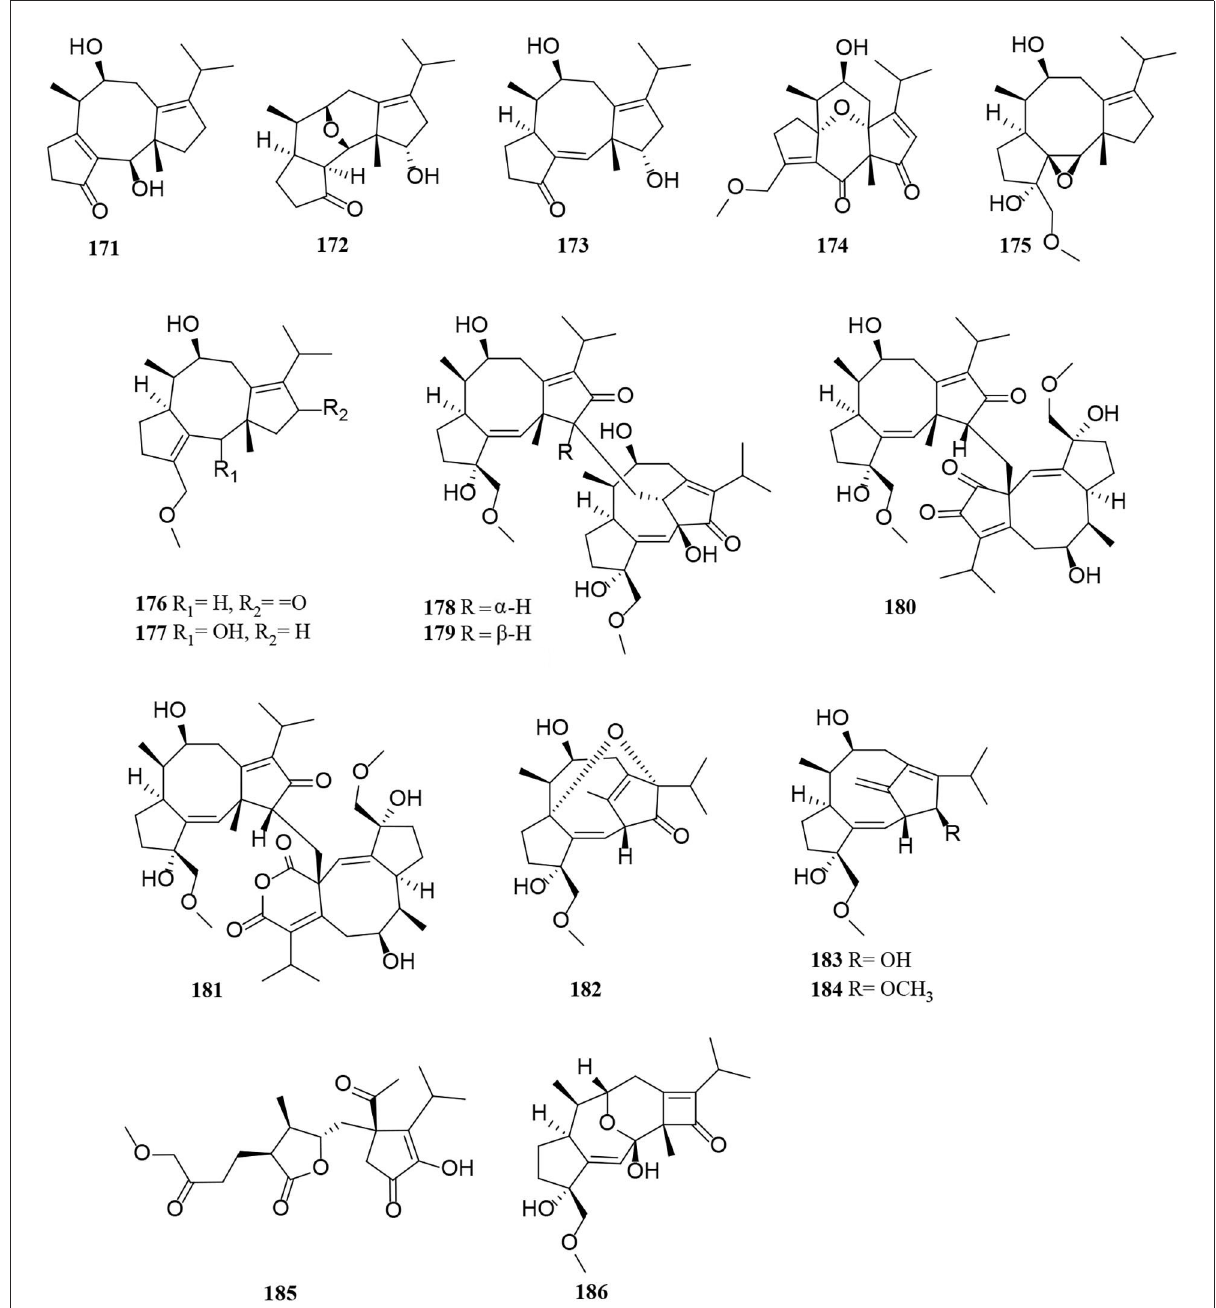
FIGURE11 Diterpene derivatives ( 171 – 186 ) from Alternaria fungi.